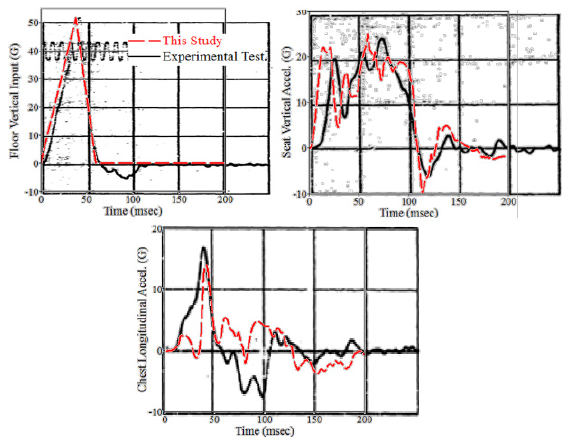
Figure 11. Comparison of results from this study with results from experimental study for a 95 th -percentile occupant on an energy-absorbing seat [27].